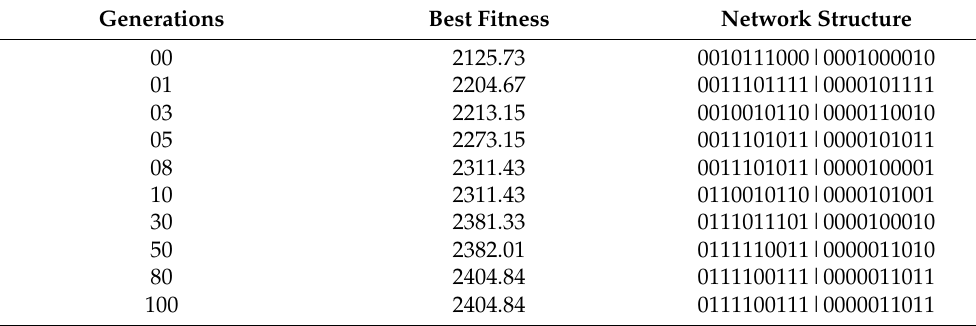
Table 9. The best fitness and corresponding network structure in Dataset